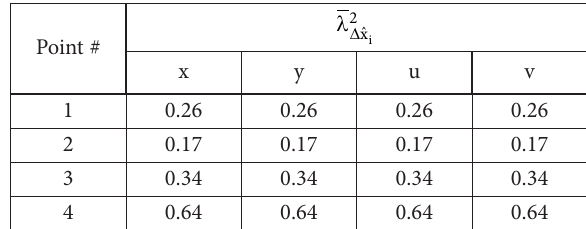
Table 3. The global external reliability. The values displayed are without multiplication by a coefficient δ u 2 i ( )